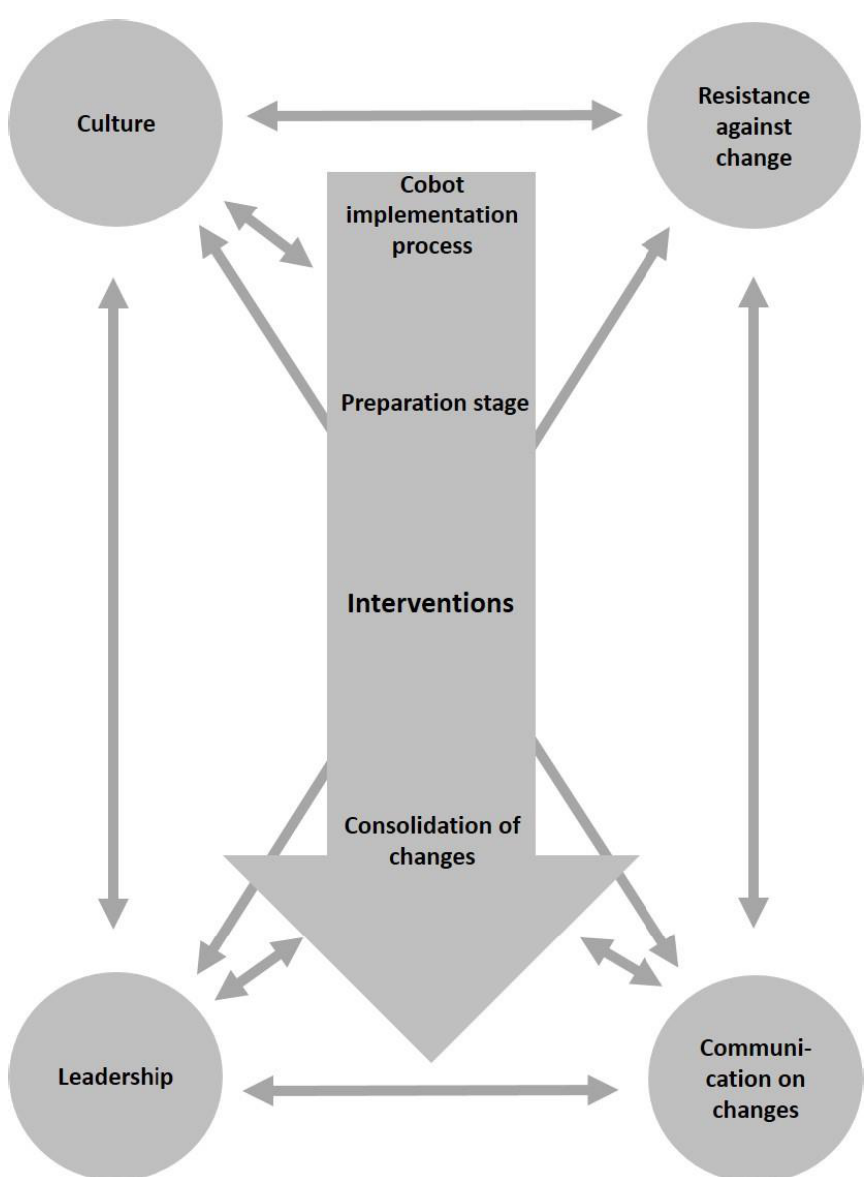
Figure 1. Human factors research model (based on [35,40]).